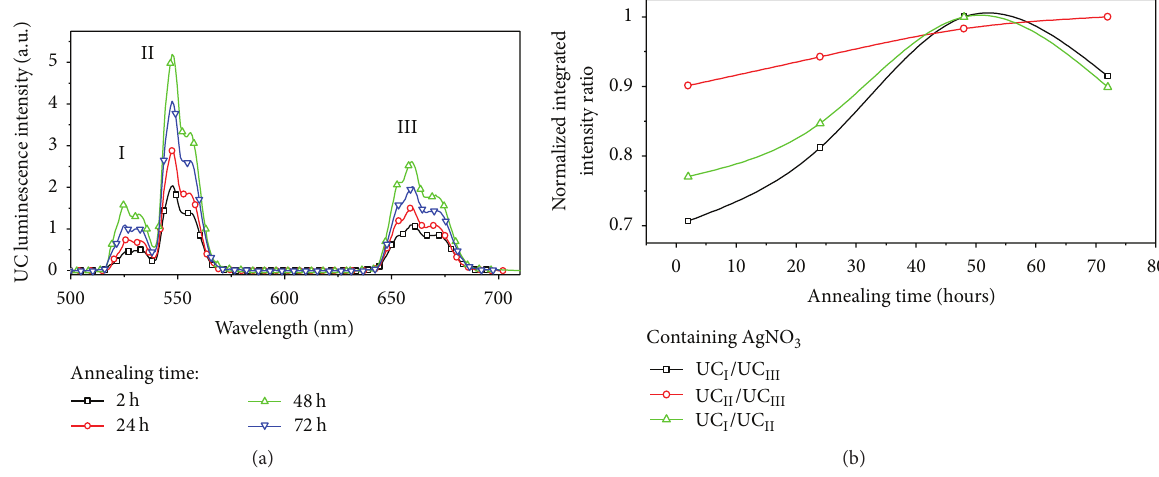
Figure 6: (a) Frequency upconversion spectra of the of Er 3+ /Yb 3+ codoped PbO-GeO 2 glasses containing silver NPs for different heat- treatment times. (b) Normalized integrated upconversion intensity (UC I : peak centered at 525 nm, UC II : peak centered at 550 nm, and UC III : peak centered at 662 nm) as a function of the annealing time [2].